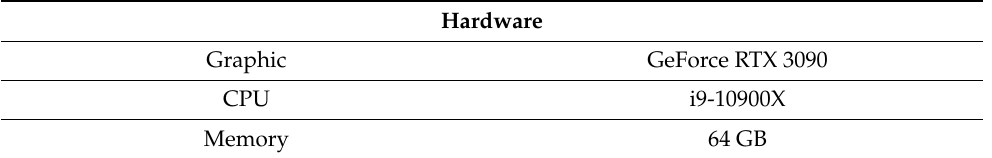
Table 3. Model learning environment